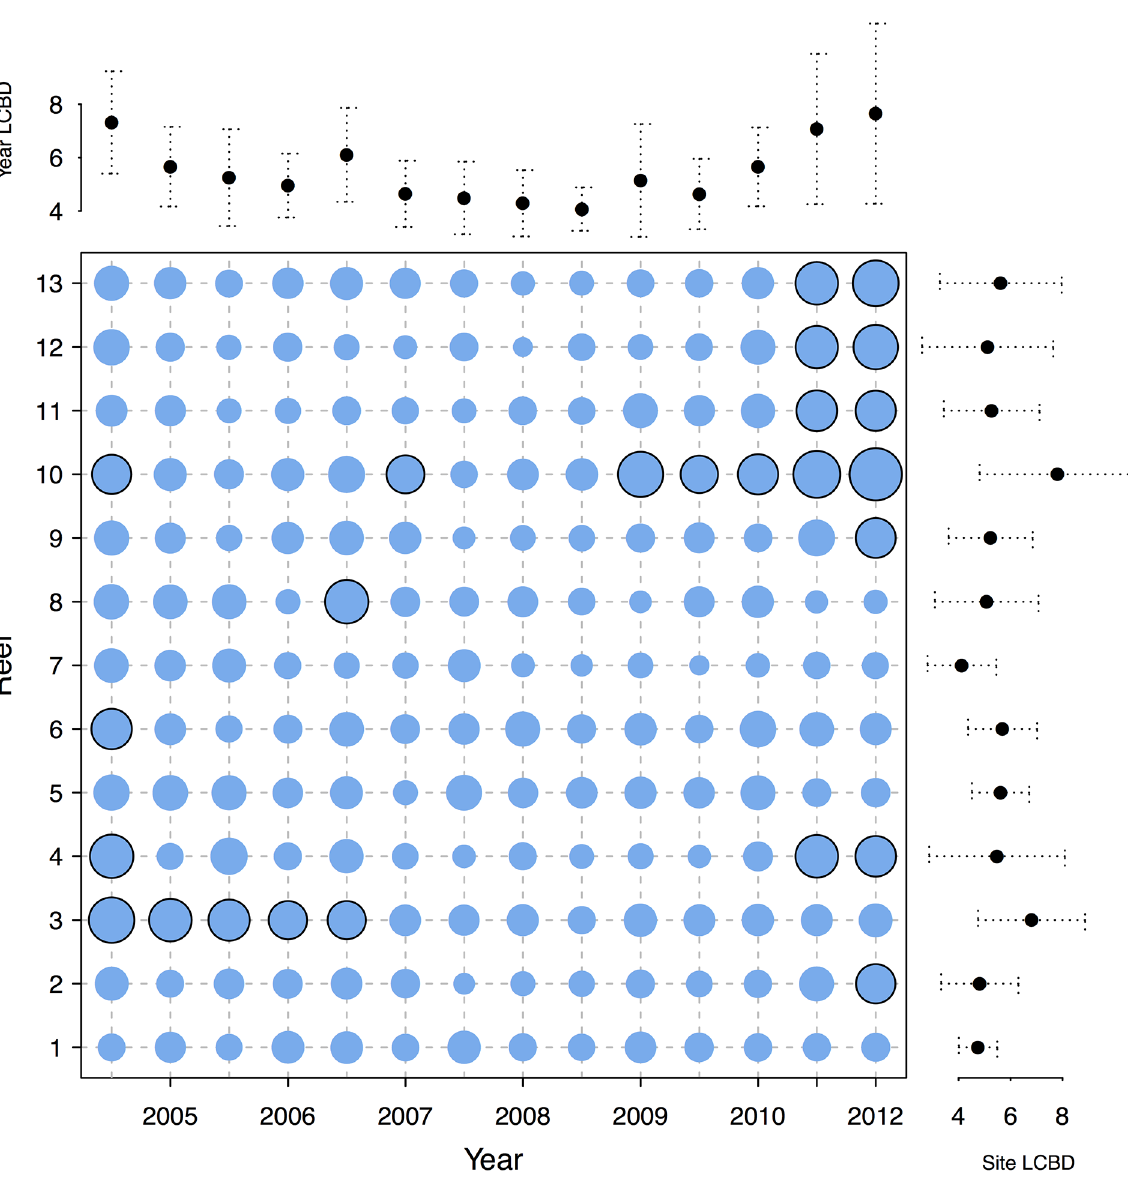
Fig 3. Local contributions to beta diversity (LCBD) per reef and year. LCBD values indicate the extent to which each local community is unique in terms of its composition. Circle surface areas are proportional to the LCBD values. Circles with a black rim indicate significant LCBD indices at the 0.05 level. Marginal diagrams indicate LCBD value averages per year (upper margin) and per reef (right margin); values are multiplied by 1000.